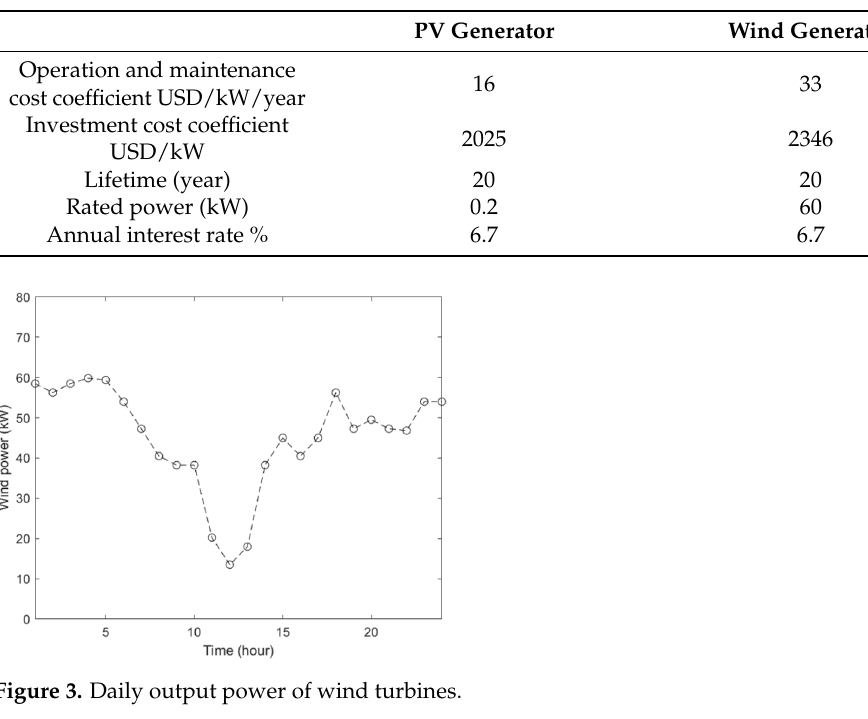
Table 2. Parameters of wind and PV generator.